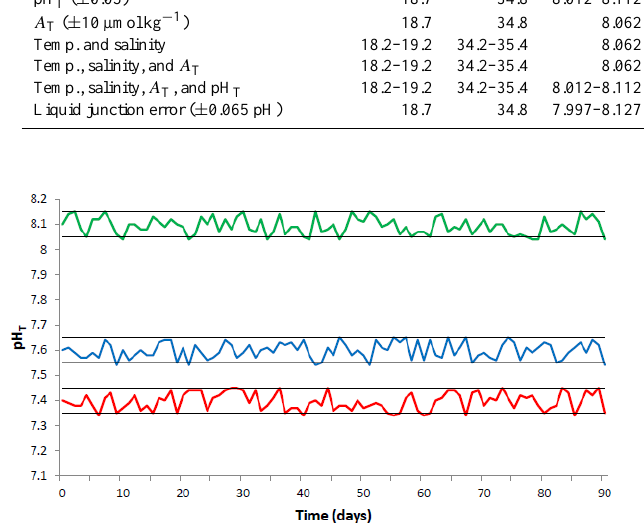
Figure 2. pH T recorded over the course of a 90-day experiment in Figure 2 pH T recorded over the course of a 90-day experiment in which snails were maintained in three 2 which snails were maintained in three culture tanks: 8.1 (green), 7.6 culture tanks: 8.1 (green), 7.6 (blue), 7.4 (red) pH T . Coloured lines represent pHT data recorded on 3 (blue), 7.4 (red) pH T . Coloured lines represent pH T data recorded Denver AP50 hand held pH meter and black lines represent ±0.05 error around target pH T values. 4 on Denver AP50 hand-held pH meter, and black lines represent ± 0.05 error around target pH T values.